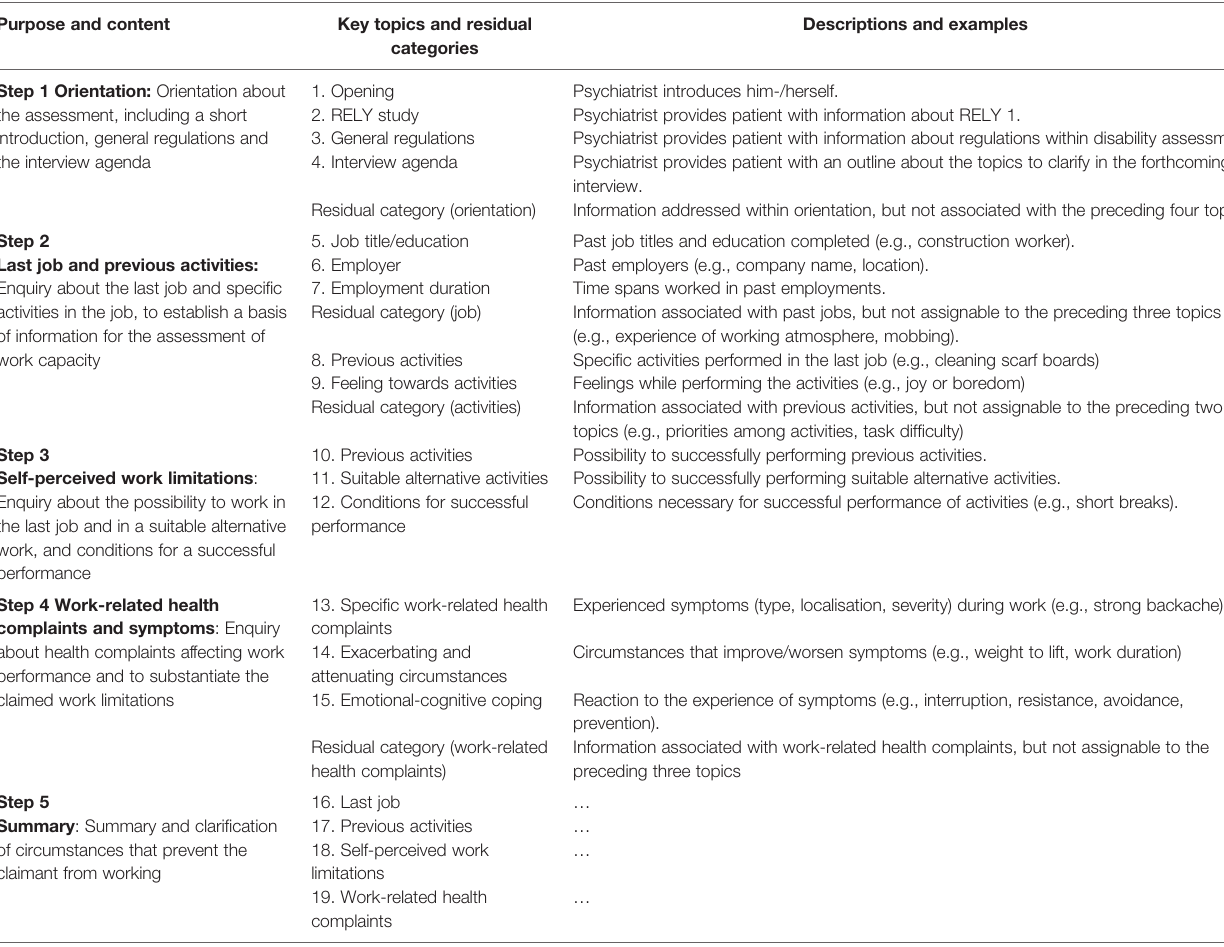
TABLE 1 | Purpose and content of functional interviewing: The fi ve steps and the category system with 19 key